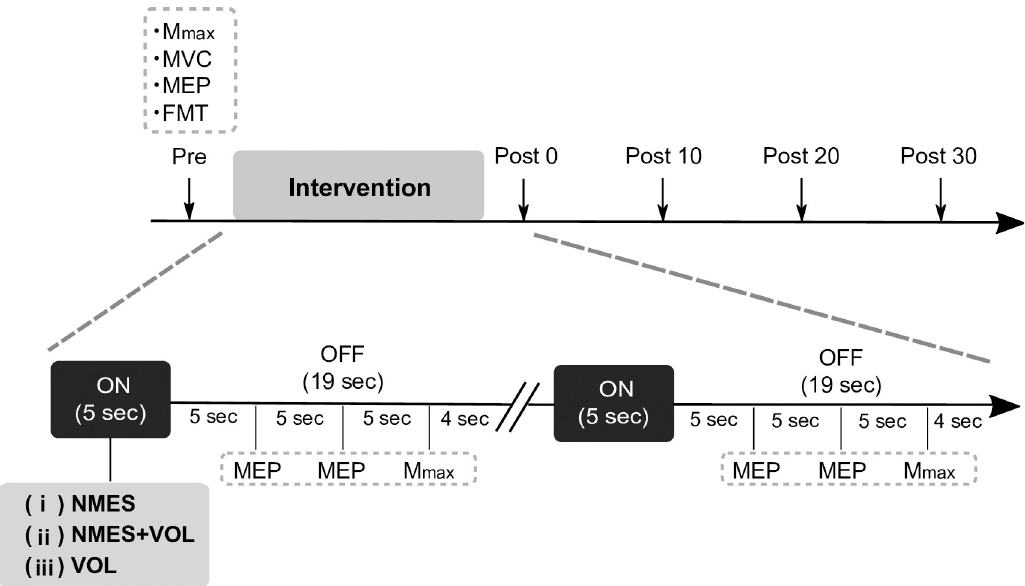
Fig 2. Time course of the experimental protocol. Participants performed three interventions: (i) NMES alone; (ii) NMES+VOL; and (iii) VOL alone. The assessments of MEP and M max were measured before starting the interventions (Pre), during the interventions in the NMES OFF periods (During1 (0–4 min), During2 (4–8 min), During3 (8–12 min), During4 (12–16 min)), as well as immediately (Post0), 10 min (Post10), 20 min (Post20), and 30 min (Post30) after the interventions. Abbreviations: FMT, force-matching task; MEP, motor evoked potential; MVC, maximum voluntary contraction; NMES, neuromuscular electrical stimulation; VOL, voluntary contractions.